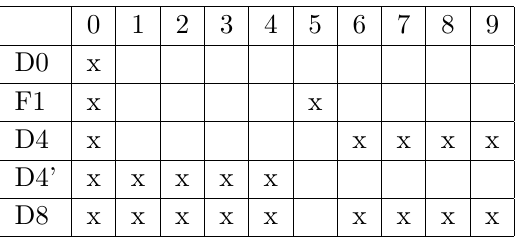
Table 5 . 1 -BPS brane intersection underlying the AdS 2 (cid:2) S 3 solutions in Type IIA. ( x 1 ; : : : ; x 4 ) 8 span the CY 2 and ( x 6 ; x 7 ; x 8 ; x 9 ) are the transverse directions on which the SO(4) symmetry group is realised. A N = 4 supersymmetric quantum mechanics lives in the common x 0